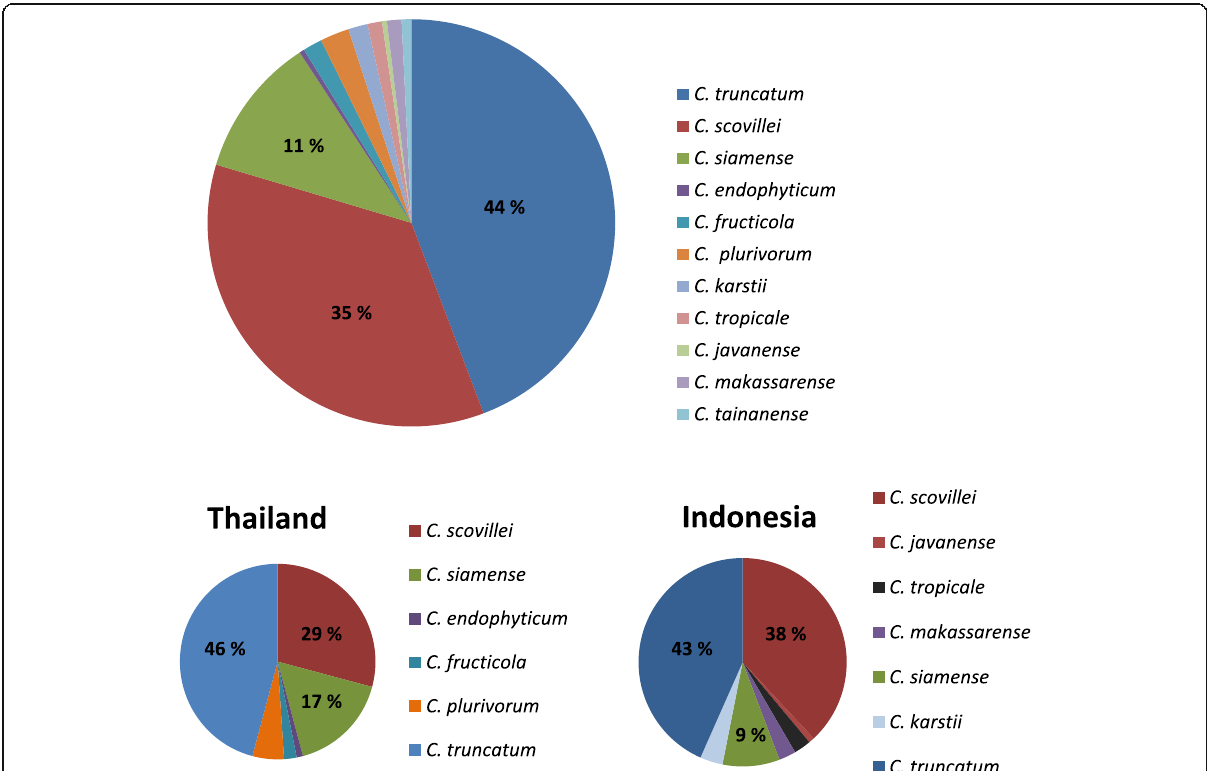
Fig. 9 Prevalence of Colletotrichum species as a percentage of the total isolates collected in all regions and in Indonesia and Thailand